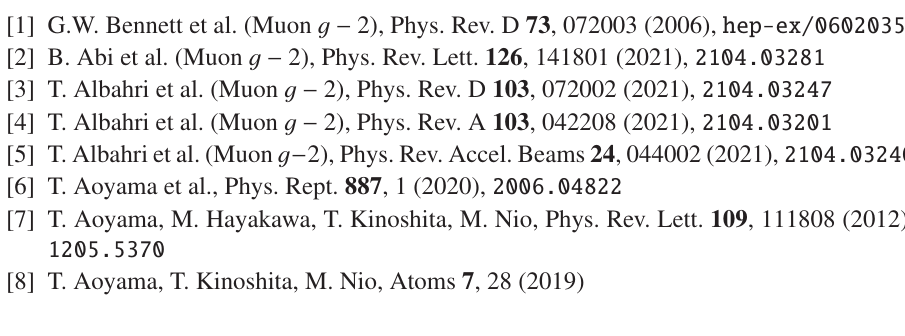
Figure 3. Constraints on the antisymmetric TFFs of the f 1 (1285) in terms of couplings C a two variants of vector-meson-dominance parameterizations; from Ref. Figure 2. Comparison of the longitudinal short-distance contributions as a function of a common lower cuto ↵ Q min on the virtualities in the HLbL loop integral. The red dashed line refers to the perturbative QCD quark loop, the others to Ref. [19] (MV), Ref. [71] (CCDGI), Ref. [70] (HW2), Refs. [30, 31] (excited PS), and Ref. [74] (LP); from Ref. [75].